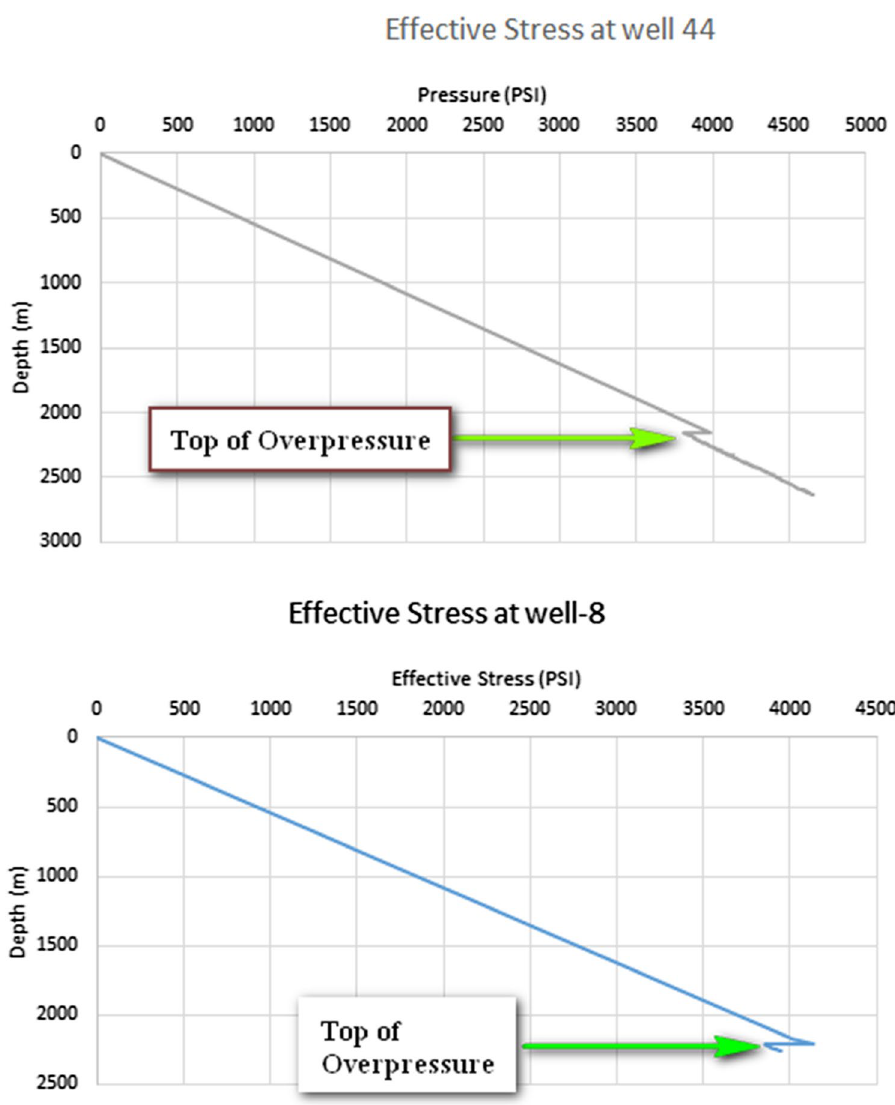
Fig. 6 Effective pressure in well no. 44 and well no. 8. As can be seen, effective pressure increases with increasing depth. Meanwhile, the effective pres- sure decreases in the overpres- sure